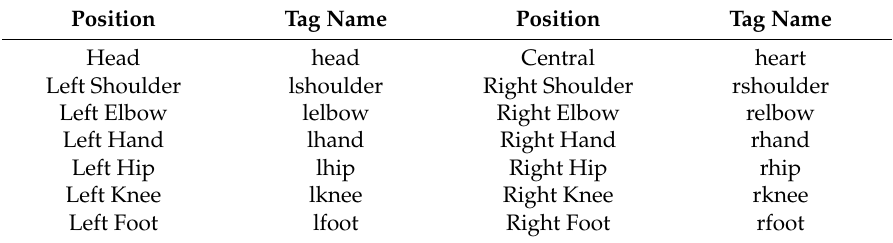
Figure 2. Distribution of UWB receiving tags. Table 1. Key joints of human body.